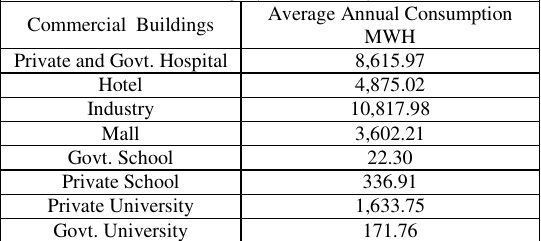
Fig. 3: Change in Green Area (Source: Forest Department of Sindh)